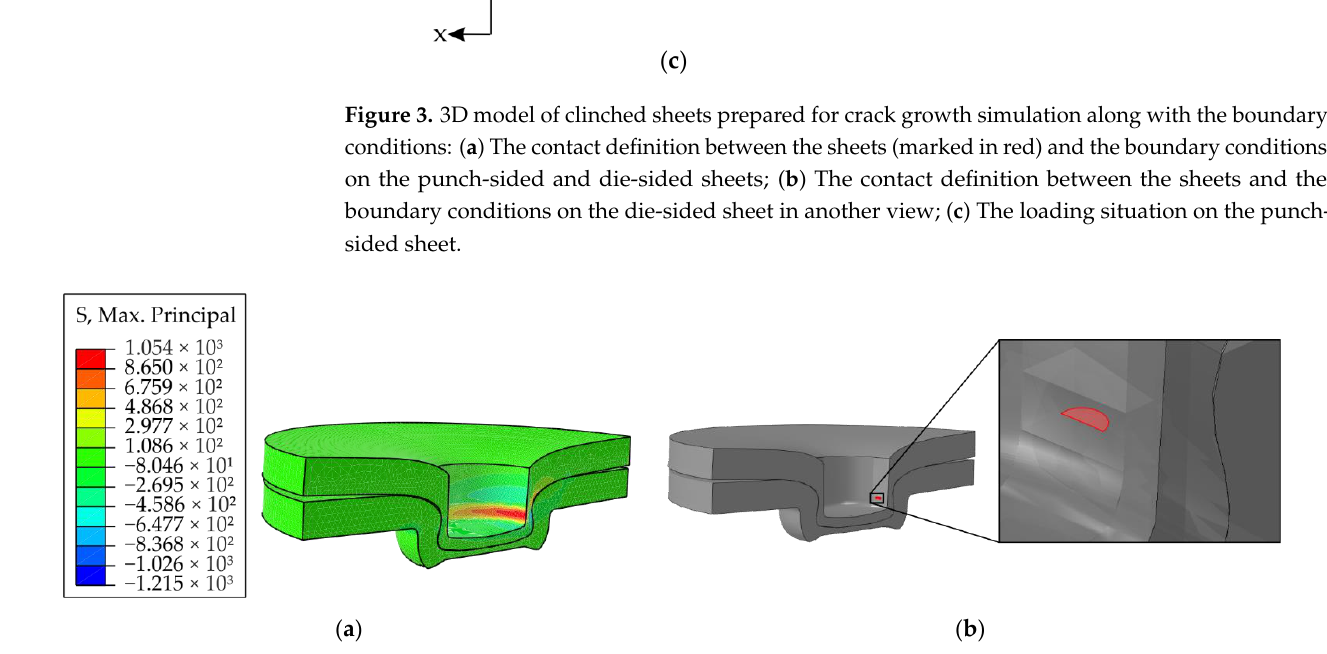
Figure 3. 3D model of clinched sheets prepared for crack growth simulation along with the bound- ary conditions: ( a ) The contact definition between the sheets (marked in red) and the boundary con- ditions on the punch-sided and die-sided sheets; ( b ) The contact definition between the sheets and the boundary conditions on the die-sided sheet in another view; ( c ) The loading situation on the punch-sided sheet.